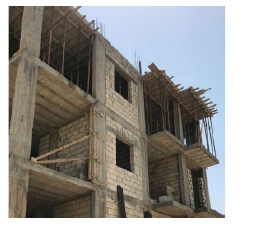
Figure 4. Messy surroundings and improper waste disposal